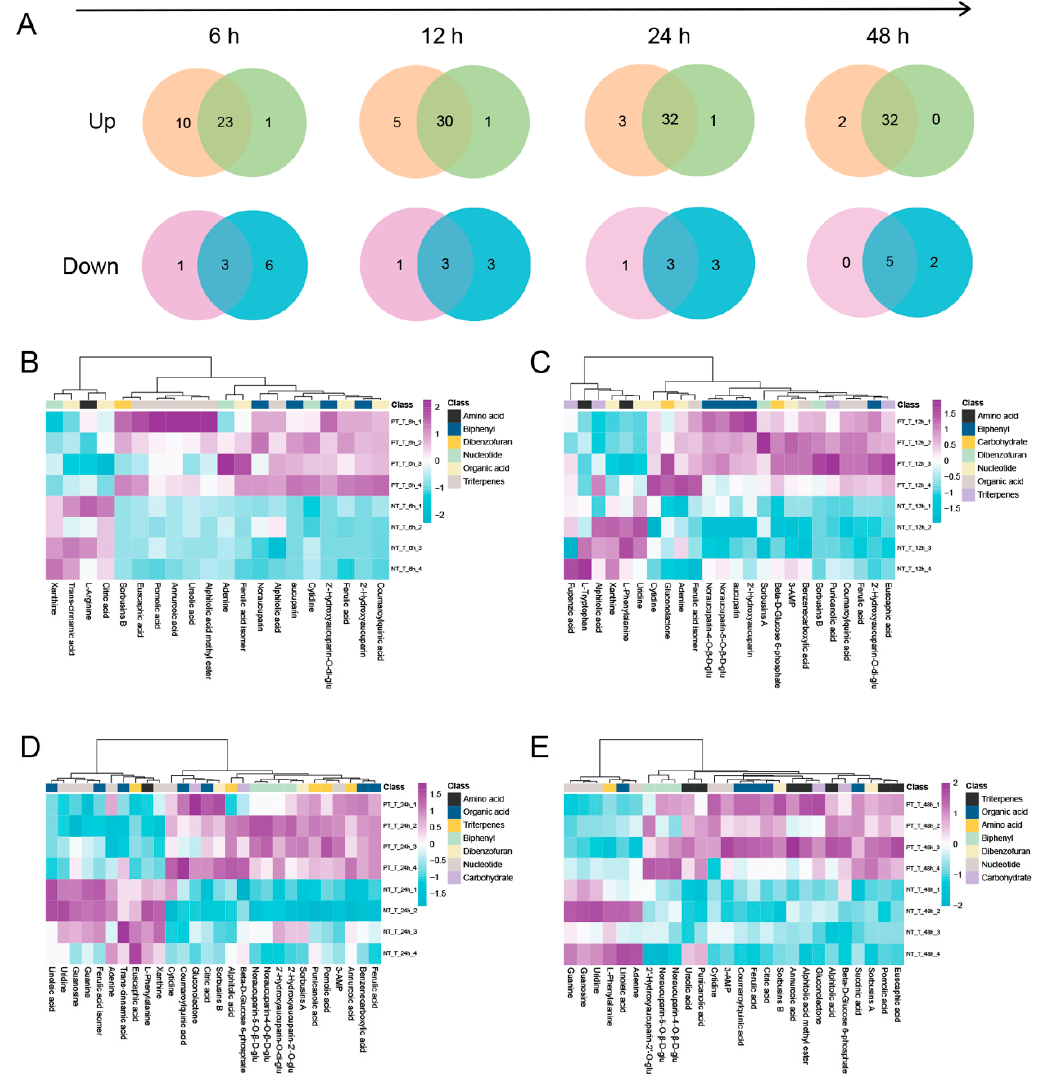
Figure 3. Global view of the distinct and common metabolites in SPSCs in response to YE. ( A ) Venn diagram showing the total number of the unique or overlapping metabolites between PT_T ( left ) and NT_T ( right ). Heatmaps of differential metabolites between PT_T and NT_T at 6 ( B ), 12 ( C ), 24 ( D ), and 48 ( E ) hours after treatment (HAT) with YE.